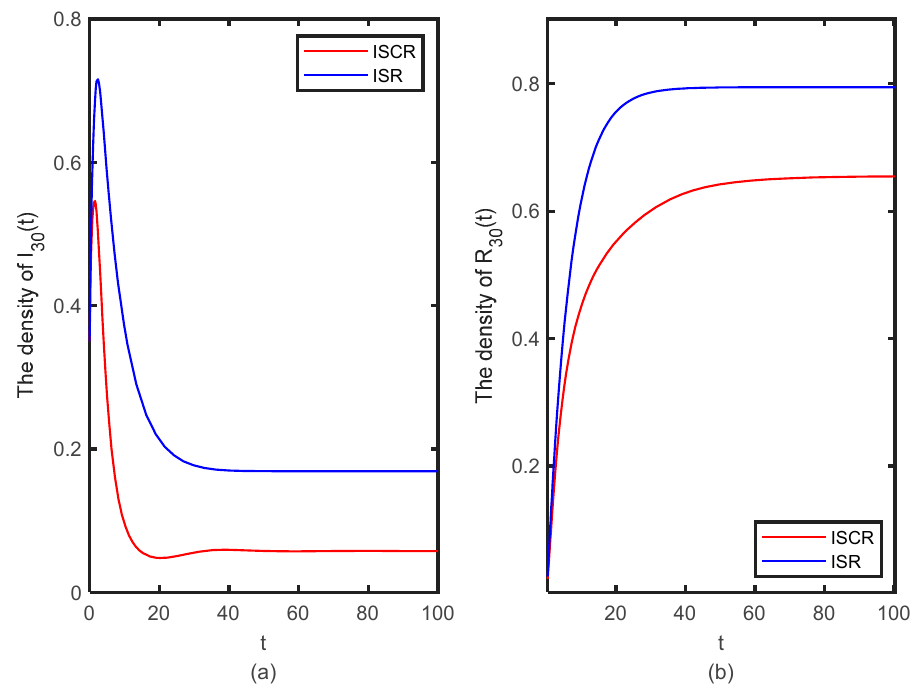
( t ) ( a ), R ( t ) ( b ) with and without the Cooling-off 30